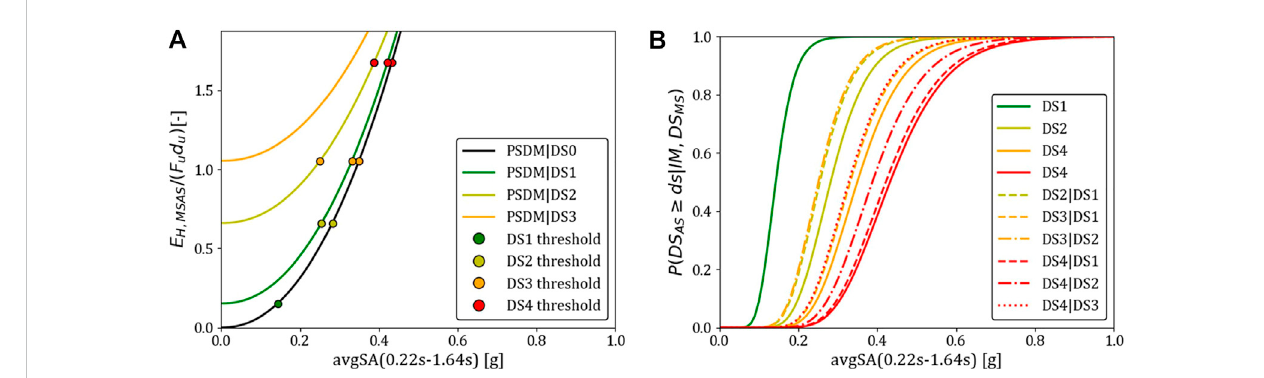
FIGURE 13 (A) PSDMs and DS thresholds for both undamaged and damage-state-dependent con fi gurations; (B) state-dependent fragility curves.